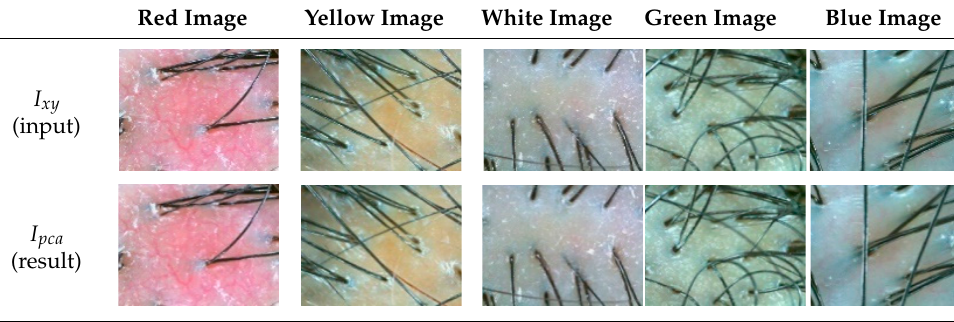
Figure 2. Some pixels are overprocessed and show a different color than the surroundings when α has a value higher than 0.5. Table 6. Examples of PCA Augmentation.